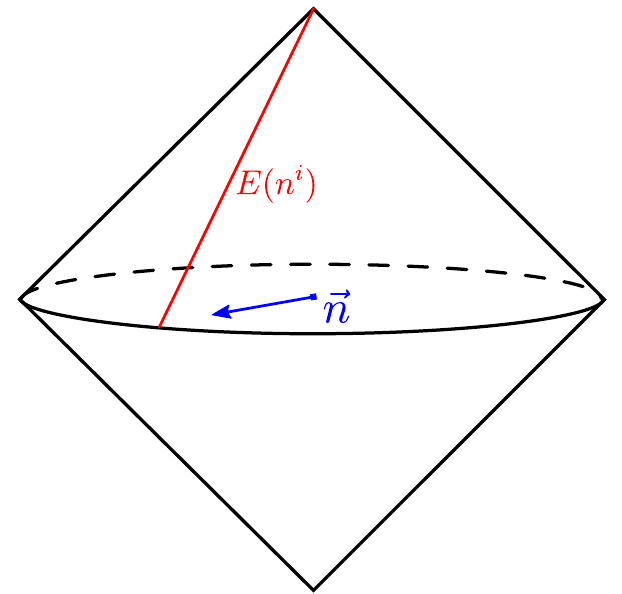
Figure 1 . The Penrose diagram of Minkowski space in three dimensions. The ANEC operator has been sent to spatial in(cid:12)nity, at a given point on the celestial sphere (here a point on the circle). It is still integrated along a null direction represented by the red line. The vector ~n indicates the direction in which the operator is